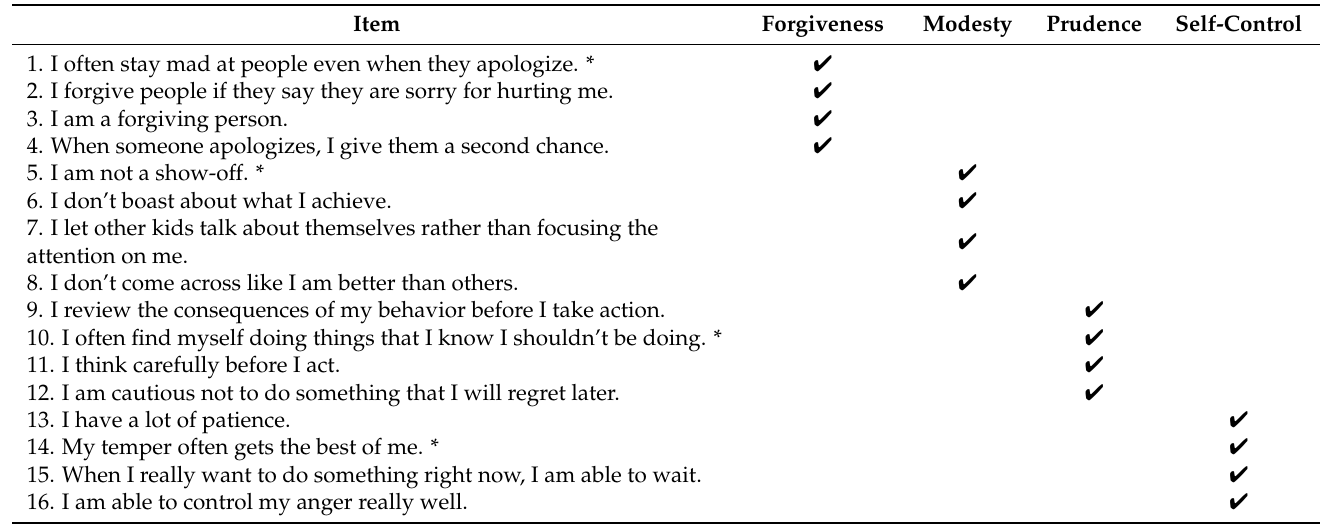
Figure 1. Factor model of temperance depicting one second-order factor structure hypothesized to underlie the four first-order factors; e—error; item—question of the temperance scale; ( a )—second-order model; ( b )—four-first-order factors model. Table 1. Temperance scale